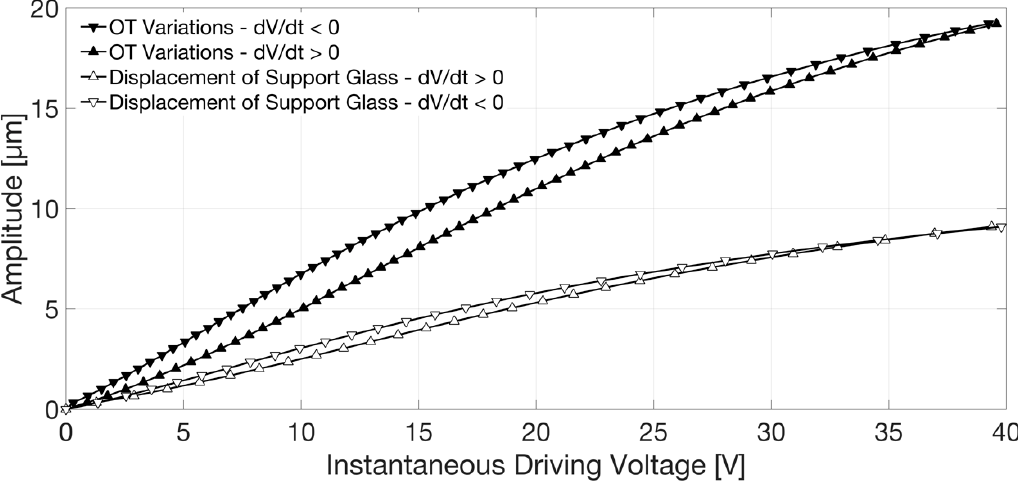
Figure 5. Amplitude of the displacement (white filled markers) of the support glass and of the optical thickness (OT) variations (black filled markers) as a function of the instantaneous driving voltage. (cid:52) : Displacement for dV/dt > 0. (cid:53) : Displacement for dV/dt < 0. (cid:78) : OT for dV/dt > 0. (cid:72) : OT for dV/dt < 0.